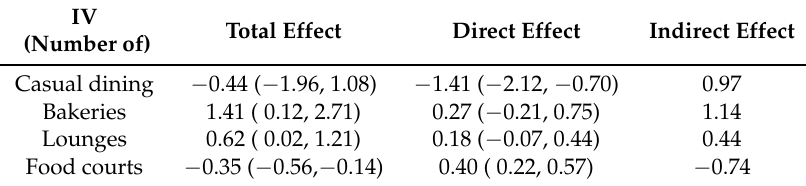
Figure 4. Diagram illustrating the mediation model: ( i ) denotes the total effect of the independent variable on the dependent variable ( ii ) denotes the indirect effect of the independent variable on the dependent variable through the mediator variable (paths A, B)) and the direct effect (path C). Table 5. Mediation results: total, direct and indirect effects (number of dining profiles as the mediator variable) with total dining posts DP total as the dependent variable. Regression coefficient with 95% CI. Only the significant ( p < 0.05) independent variables ( IV ) are reported. Total effect represents the regression coefficients of IV without considering the mediator variable ( step 1: IV → DV ), Direct effect represents the regression coefficients of IV in step 4 : IV → M → DV , IV → DV . The indirect effect is the difference between the these two